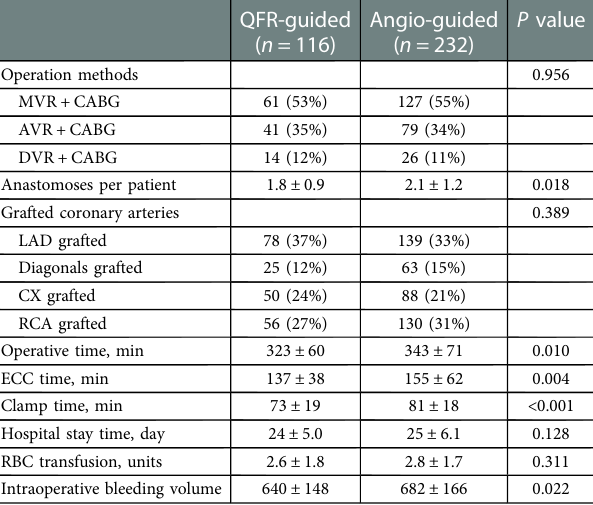
TABLE 3 Operative outcomes